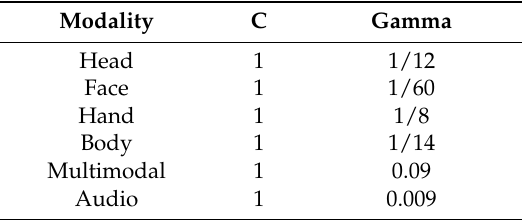
Table 6. SVM parameters for